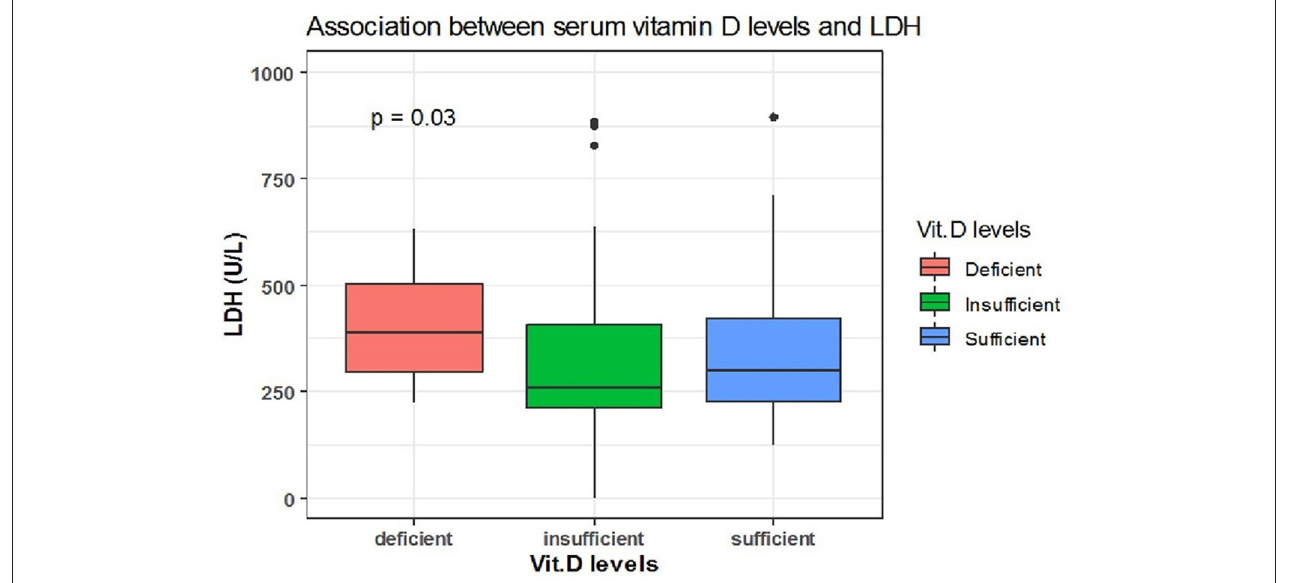
FIGURE 1 | The association between serum 25(OH)D levels (sufficient, insufficient, deficient) and LDH (U/L).